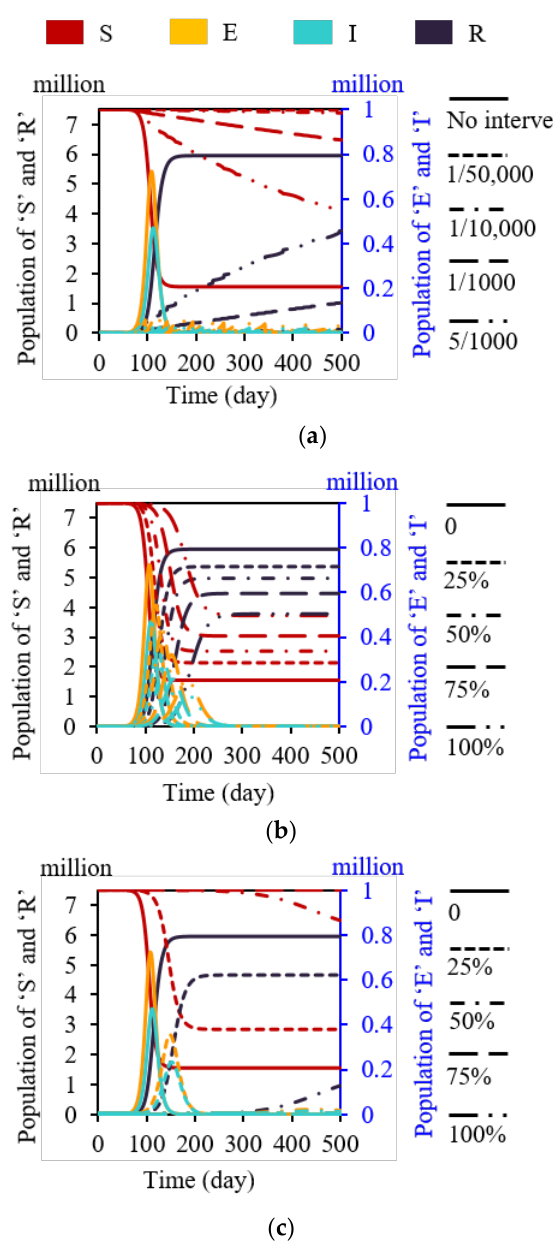
Figure 6. Effectiveness of the time and proportions of other intervention implementations. ( a ) All residents would perform NAT 1 when the number of infected exceeded a certain proportion). ( b ) residents would perform NAT 1 when the number of infected exceeded a certain Correctness of body temperature screening in public places 2 . ( c ) Close contact reduction rate (based on the daily close contact time of residents before the COVID-19 pandemic in Hong Kong). 1 Sensi- tivity of NAT was 84.8%. 2 Public places including schools, workplaces, supermarkets, public transport, shopping centers, and restaurants.